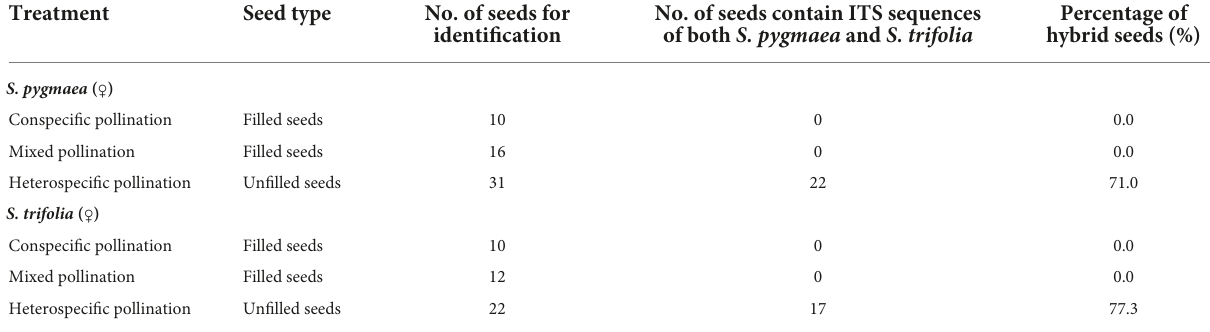
TABLE 1 Molecular characterization of seeds between Sagittaria pygmaea and S. trifolia obtained from hand-pollination treatments. Treatment Seed type No. of seeds for